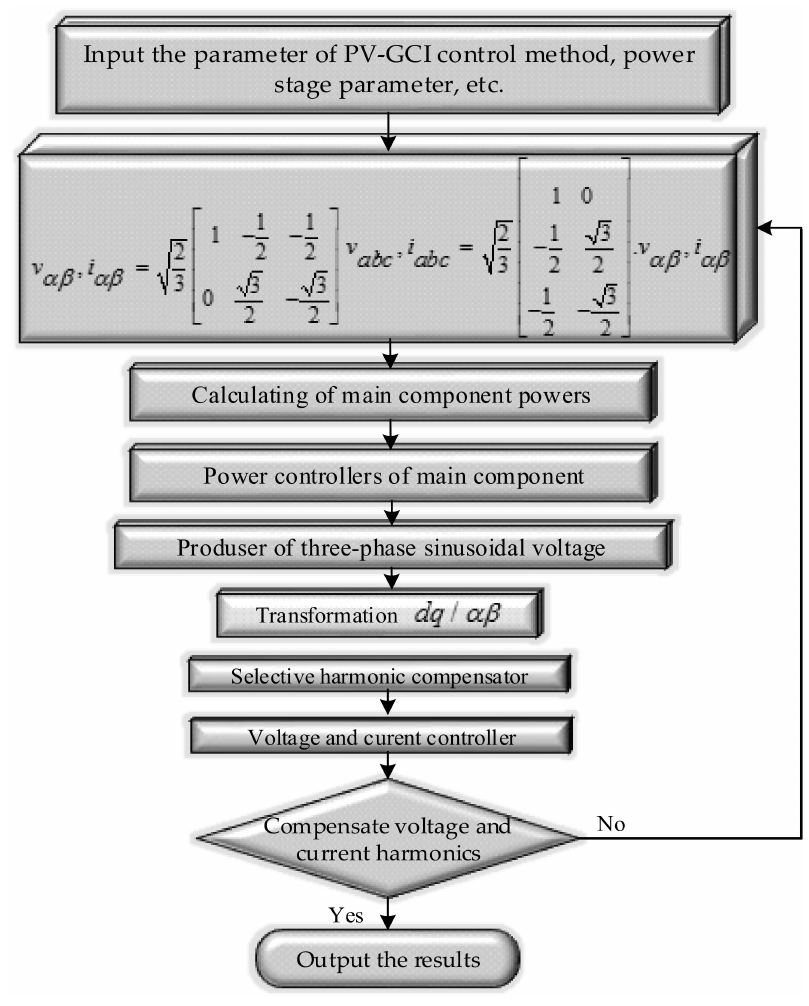
Figure 2. Flowchart of the control method of photovoltaic-grid-connected inverters